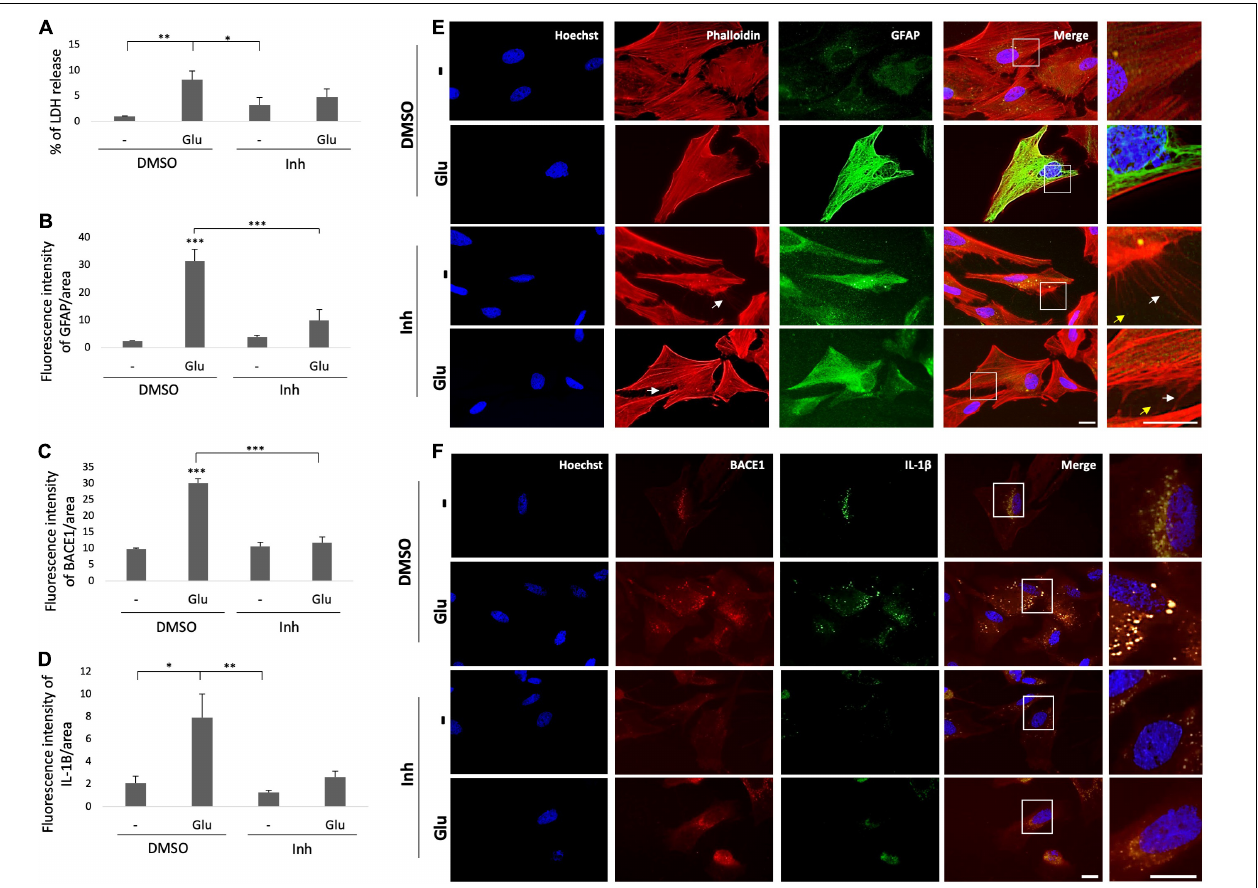
FIGURE 6 | BACE1 inhibition reduces astrocytic reactivity and induces filopodia-like processes. (A) Astrocytic cytotoxicity expressed as the percentage of LDH release after 24 h of treatment. The data are presented as the means ± SEM of n = 8. Kruskal-Wallis test followed by Dunn’s test with Bonferroni correction. (B) FI of GFAP per unit area, quantified from 20 cells per treatment for each n ( n = 4) and divided by unit area. The data are presented as the means ± SEM. ANOVA followed by Tukey’s test. (C) FI of BACE1 per unit area, quantified from 20 cells per treatment for each n ( n = 4) and divided by unit area. ANOVA followed by Tukey’s test. (D) FI of IL-1 β per unit area, quantified from 20 cells per treatment for each n ( n = 4) and divided by unit area. (E) Morphological characterization of astrocytes showing the nuclei stained with Hoechst (blue), the F-actin cytoskeleton visualized with Alexa Fluor 594 phalloidin (red), and GFAP visualized with Alexa Fluor 488 (green). Magnification: 60x. Scale bar: 20 µ m. In the zoomed insets, the white arrows indicate projections of the actin cytoskeleton, and the yellow arrows indicate extracellular GFAP IR puncta. (F) Representative images showing BACE1 (red, visualized with Alexa Fluor 594) and IL-1 β (green, visualized with Alexa Fluor 488) expression in primary astrocytes under different treatments. The zoomed insets show the distributions of both proteins and an apparent perinuclear colocalization in vesicles (yellow). Magnification: 60x. Scale bar: 20 µ m. DMSO = vehicle, Inh = β -secretase inhibitor IV, - or Glu refers to glutamate treatment. Kruskal-Wallis test followed by Dunn’s test with Bonferroni correction. The data are presented as the means ± SEM, and the experiments were performed in duplicate. * P < 0.05, ** P < 0.01, *** P <